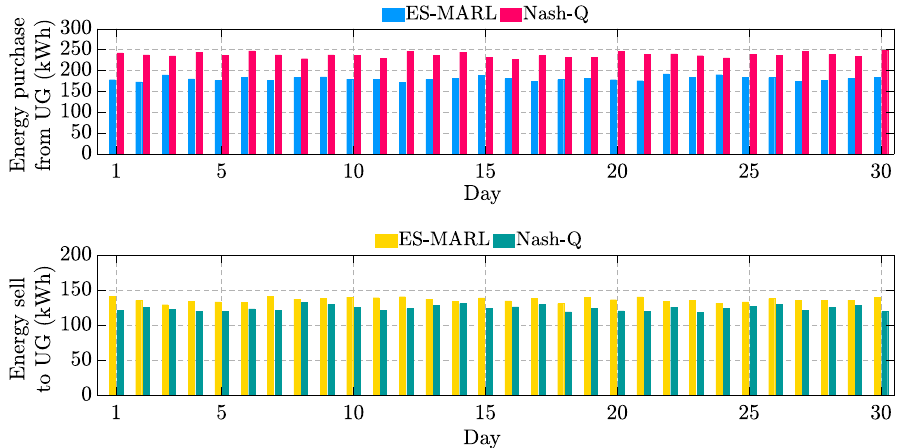
Figure 17. Energy trade with UG (purchase/sell) of ES-MARL and